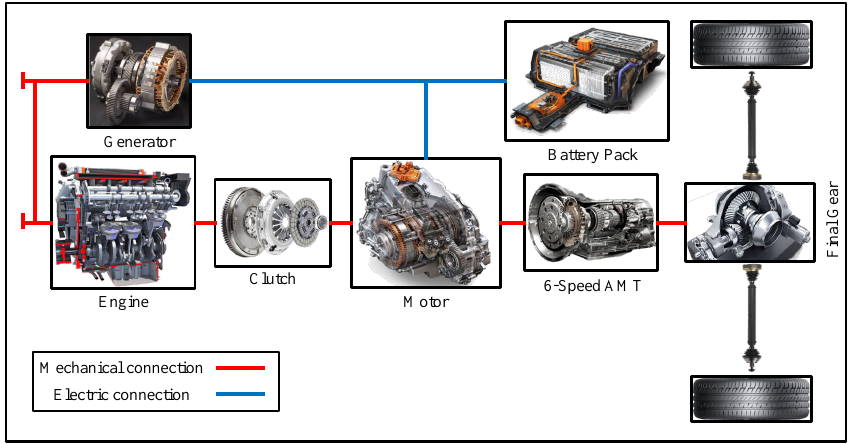
Figure 1. The architecture of the vehicle. Table 1. Vehicle configuration